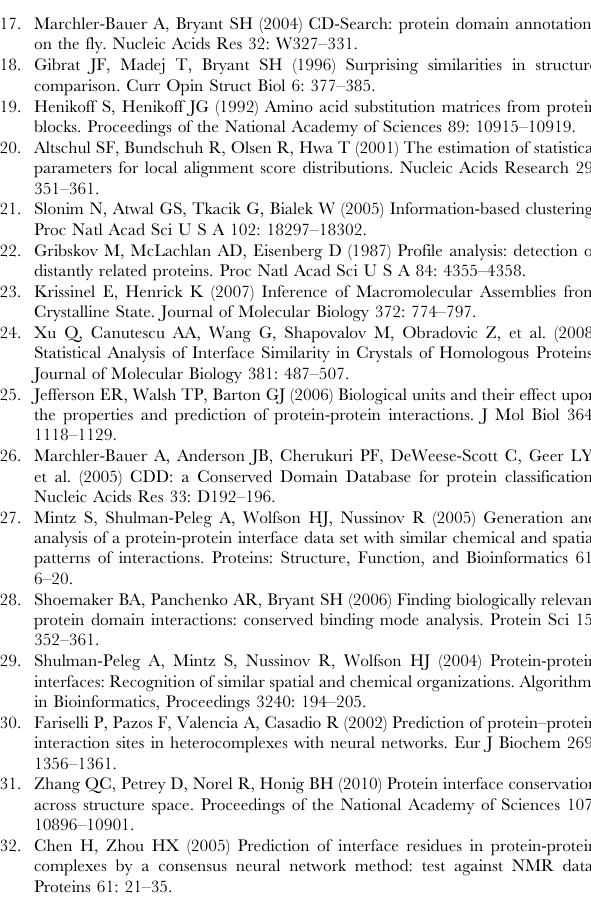
Figure S1 Distribution of oligomeric states of multi- meric structures with observed interactions in IBIS. State ‘‘ 2 1’’ correspond to structures that either could not be processed by PISA or no stable assembly was predicted by PISA. (TIF) Figure S2 Distribution of the number of chains for structures predicted as monomers by PISA but present as multimers in PDB ASU. Bin ‘‘1’’ corresponds to intra-chain domain-domain interactions. Other structures represent cases with potential crystal packing interactions. (TIF) Figure S3 Distribution of PISA predicted multimeric states for structures present as a single chain in PDB ASU.